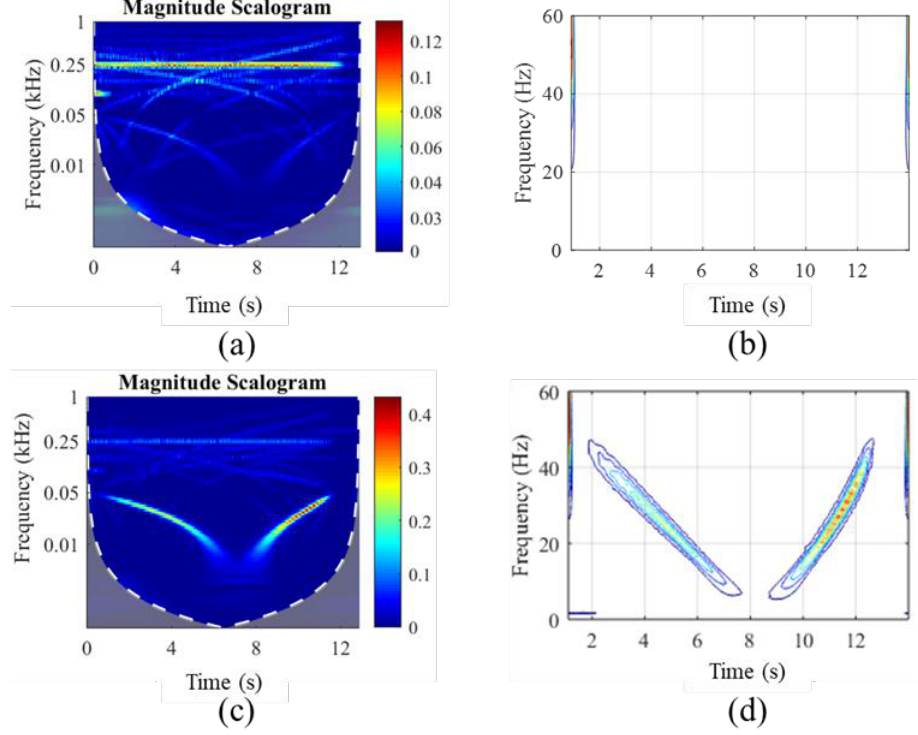
Figure 13. ( a ) The time–frequency plot of the healthy motor with 10% of the rated voltage. ( b ) The time–frequency contour plot. ( c ) The time–frequency plot for 1 BRB motor with 10% of the rated voltage. ( d ) The corresponding contour plot.